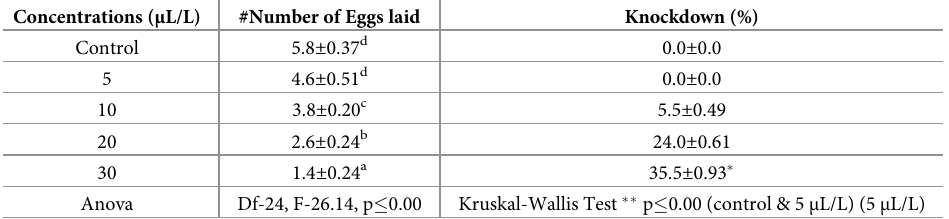
Table 6. Oviposition deterrent (number of eggs/insect/day) activity of essential oil from C . citrinus on T . Castaneum .